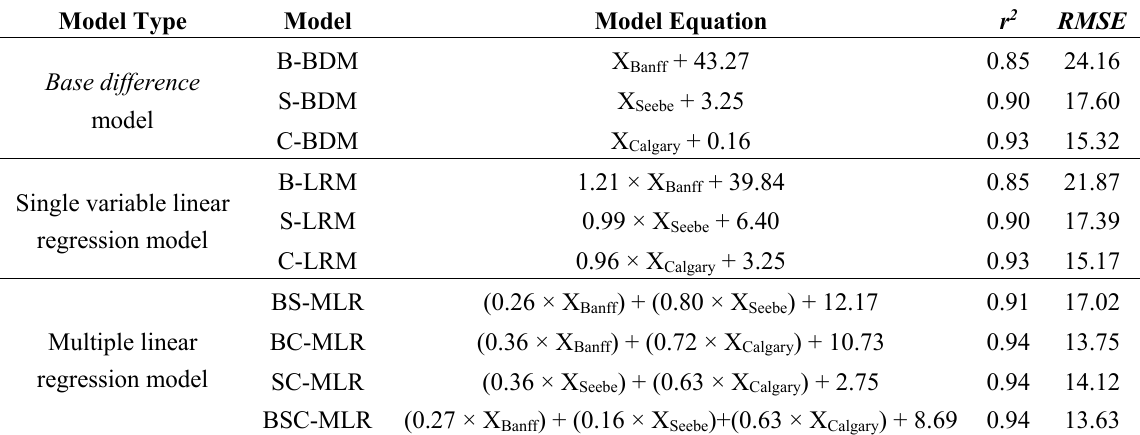
Table 2. Calibrated models and their performance